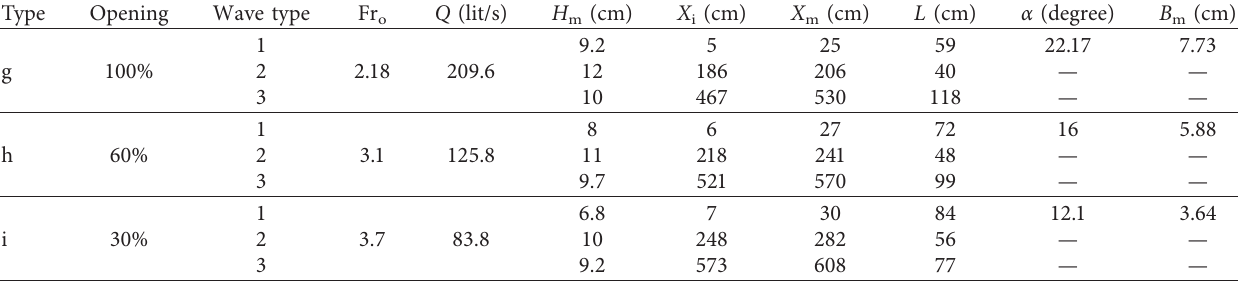
Table 3: The shockwaves’ flow characteristic for six middle gates’ operations.